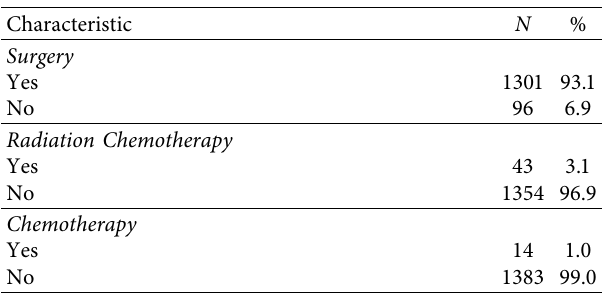
Table 1: Demographic and clinicopathological characteristics of patients with eyelid PMM,